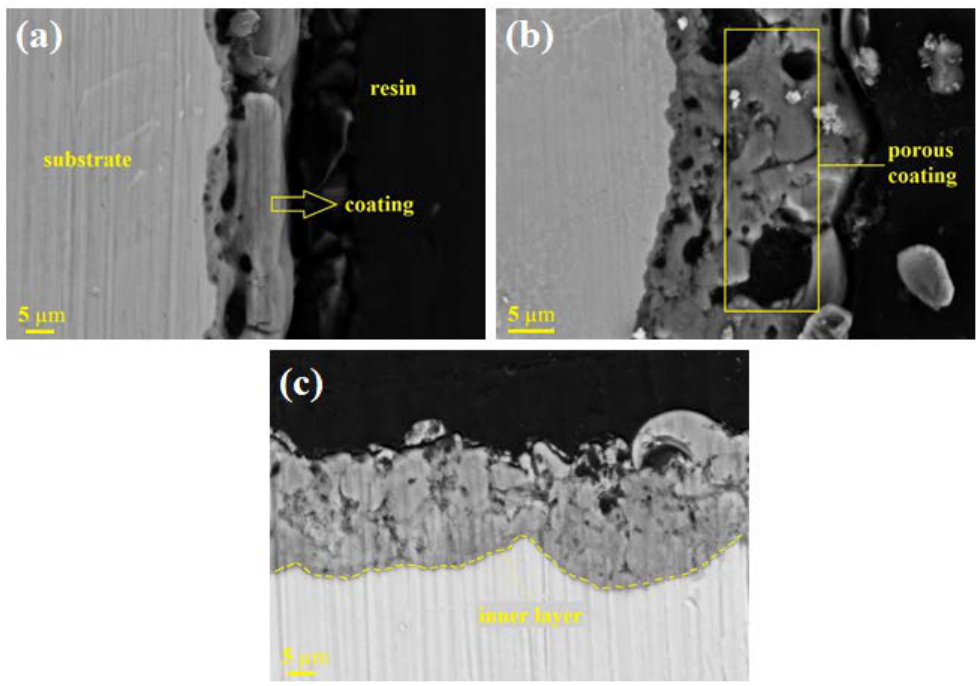
Figure 5. SEM micrographs of cross-sections of PEO-coated γ -TiAl specimens prepared under applied voltages of ( a ) 400 V, ( b ) 450 V, and ( c ) 500 V.